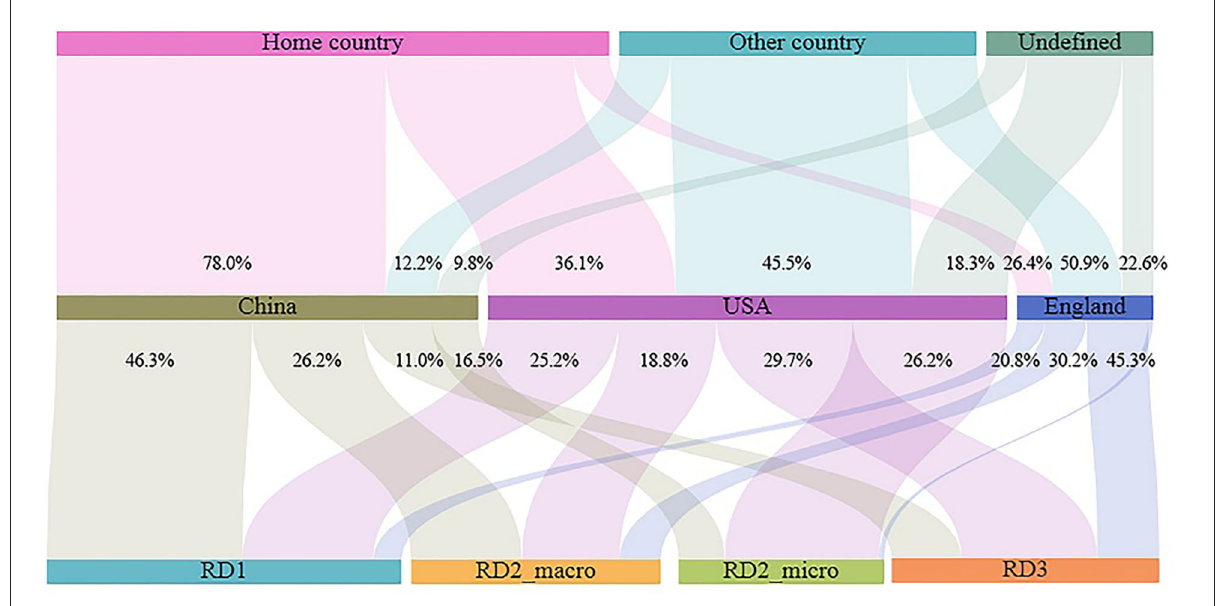
FIGURE5 Research regions and research directions in three top active countries. The length of the bars means the number of publications. The percentage figure means the number of publications in the research directions or research area as a proportion of the total number of publications in the country. The statistics were based on research areas and research directions in publications where the country was the lead author (first or second author). Home country means the home country as the study area, while other country means other countries as the study area. RD2_macro means studies that detected the influence of macro factors on the epidemiology of infectious diseases, while RD2_micro means studies that detected the words and actions of micro factors on the epidemiology of infectious